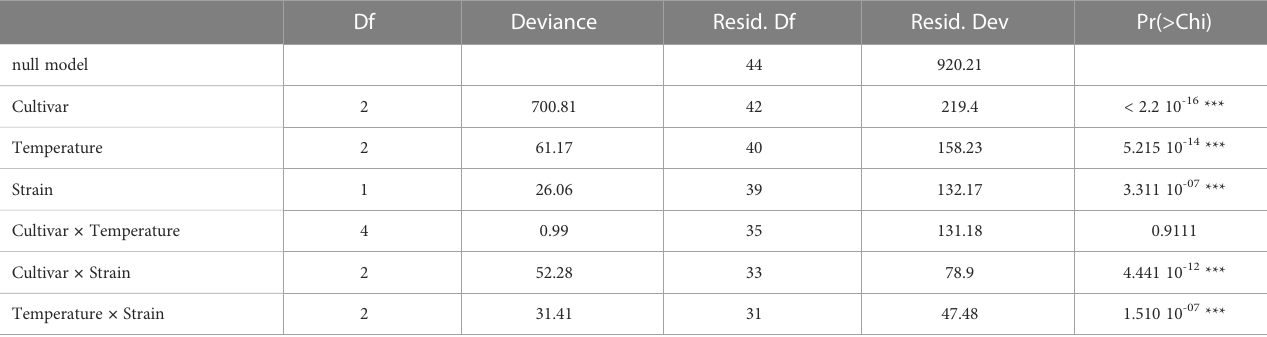
TABLE 4 Analysis of deviance for the percentage of dead plants at 28 dpi, for three M. sativa cultivars. 100 plants per variety were infected by V. alfalfae strains V31-2 and AS38, at 20°C, 25°C and 28°C, in three independent replicates and two blocks per replicate. Df Deviance Resid. Df